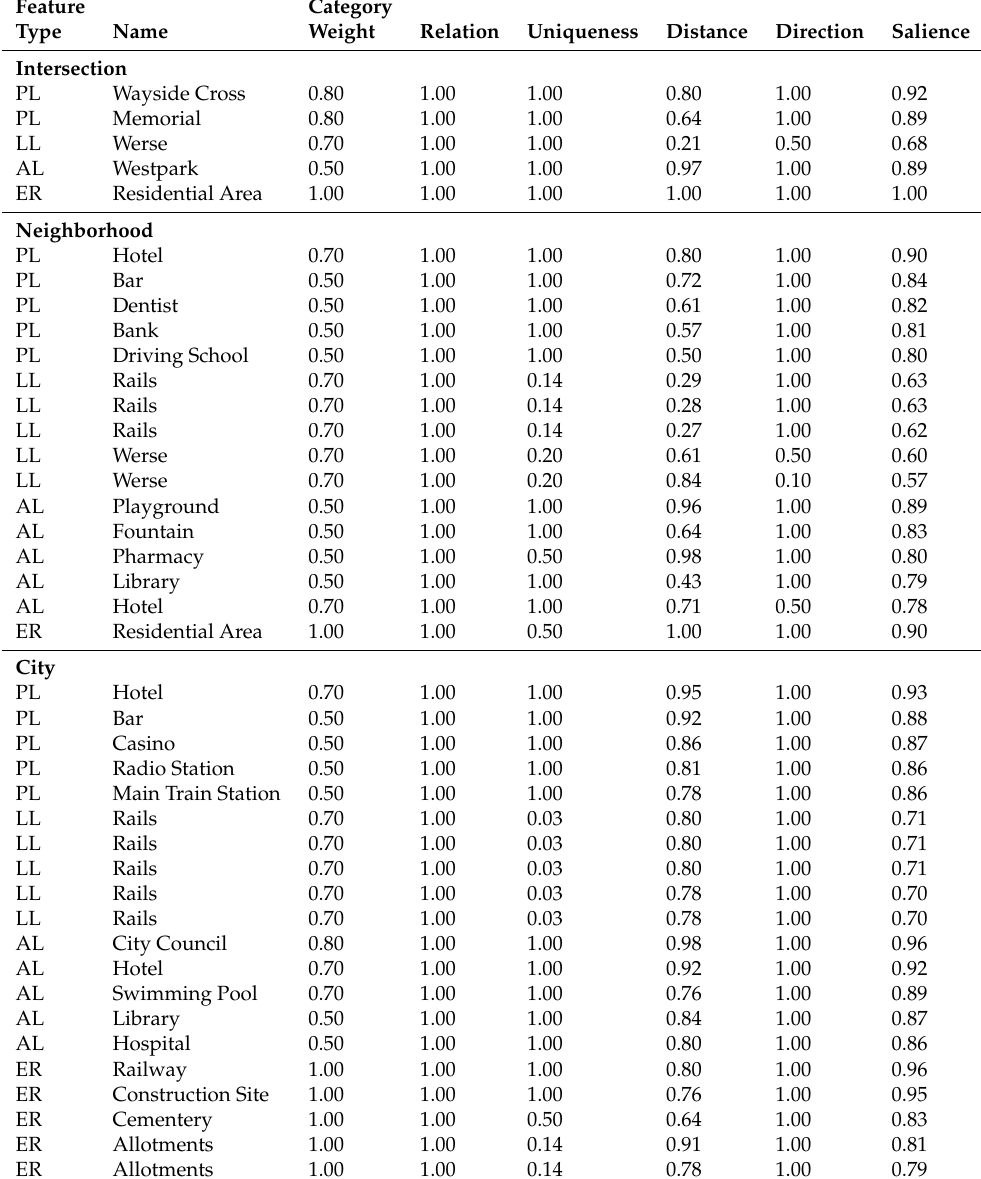
Table 6: Numerical results of case